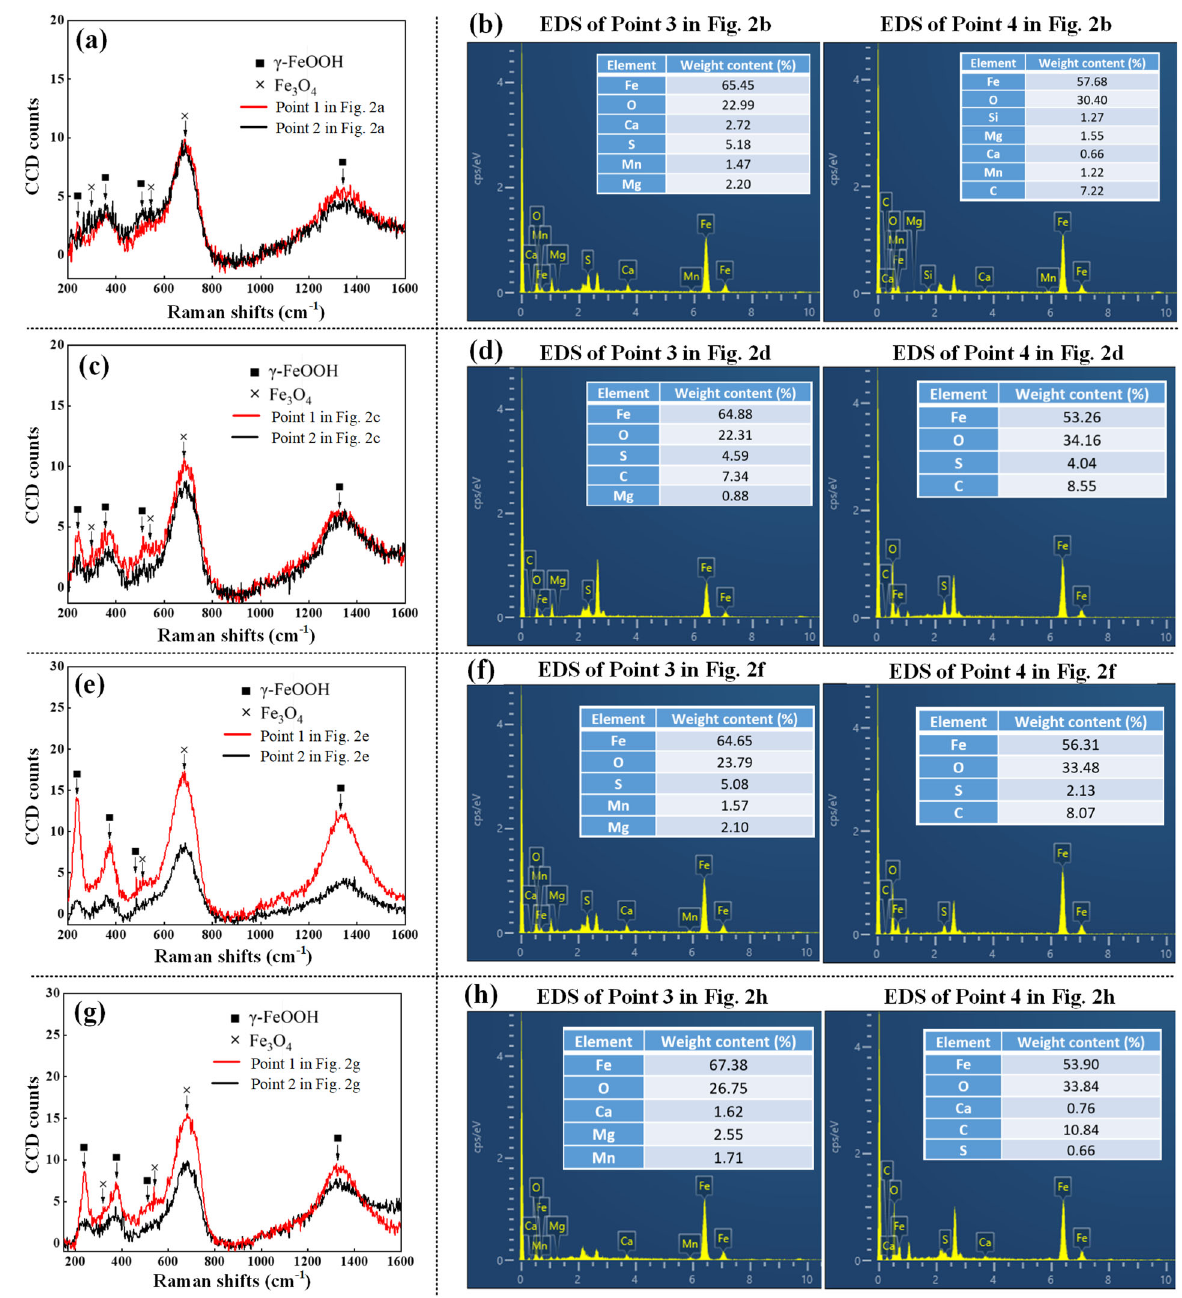
Fig. 3 Characterization of the corrosion products generated in pure natural seawater. The Raman spectroscopy ( a , c , e , g ) and EDS results ( b , d , f , h ) of the local points presented in Fig. 2 at different fl ow velocities. a , b 1 m s − 1 , c , d 3 m s − 1 , e , f 5 m s − 1 , g , h 8 m s − 1